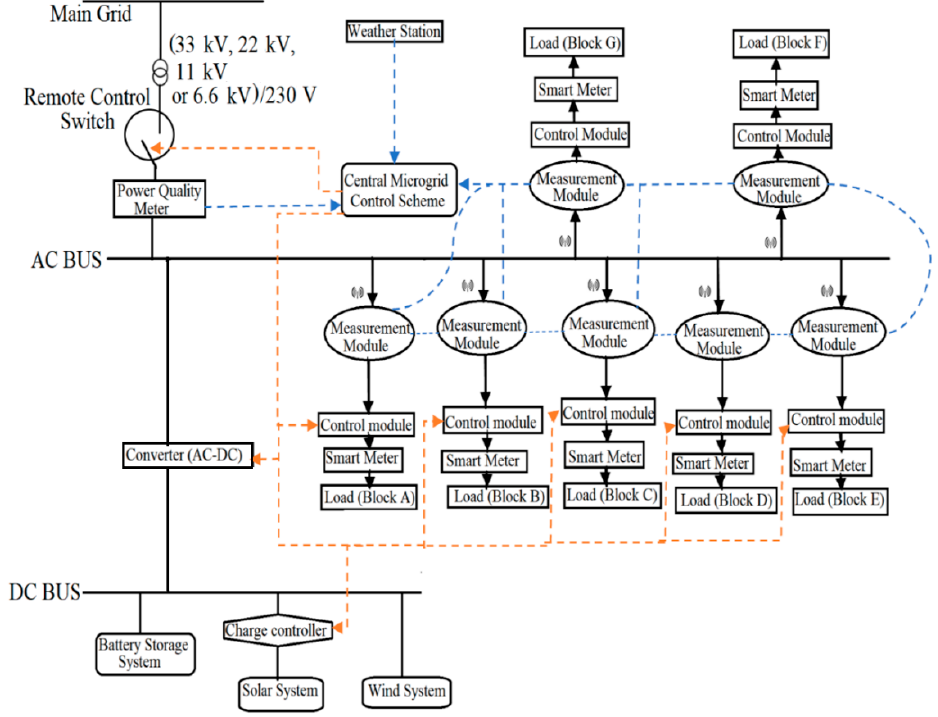
Figure 8. Proposed Microgrid System for DUT.